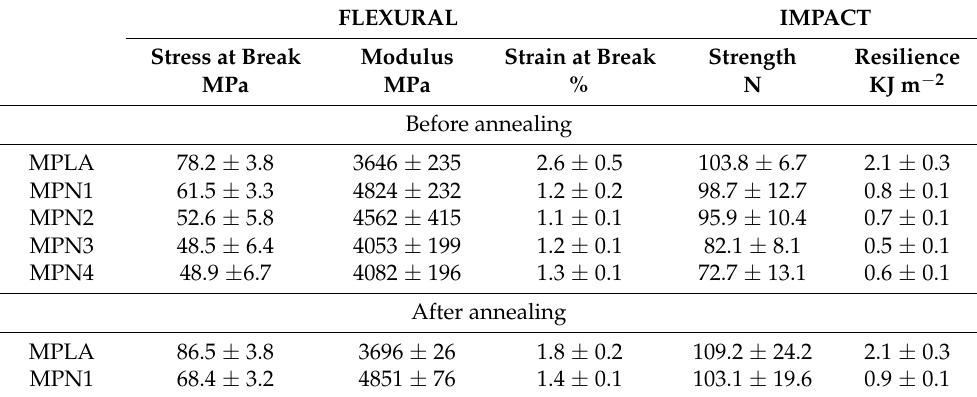
Table 5. Mechanical properties of MPLA and its